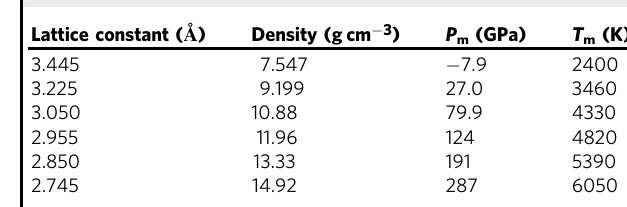
Table 1 The six ab initio melting points of body-centered cubic bcc-Nb, ( P m , T m ), obtained from the Z method implemented with VASP.